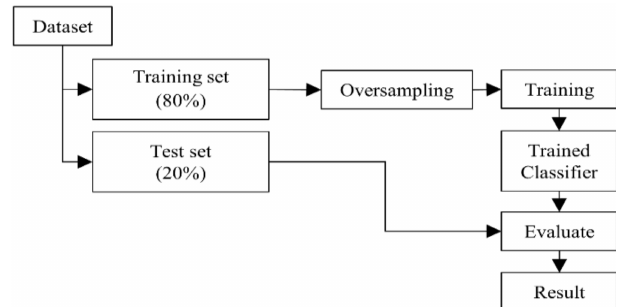
Figure 5. Process of training and evaluating the classifiers in each fold of the 5-fold cross- validation framework.